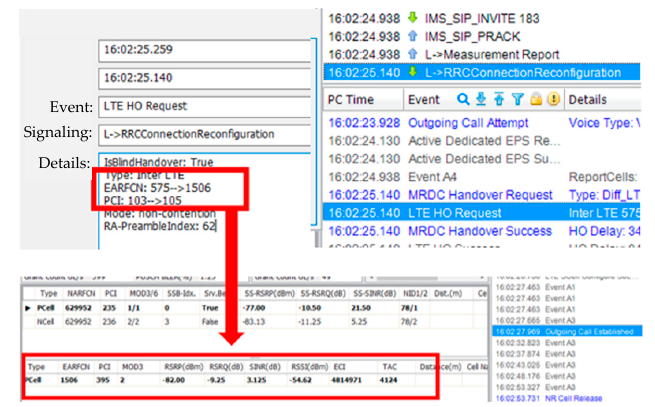
Figure 10. Sharer VoLTE setup.